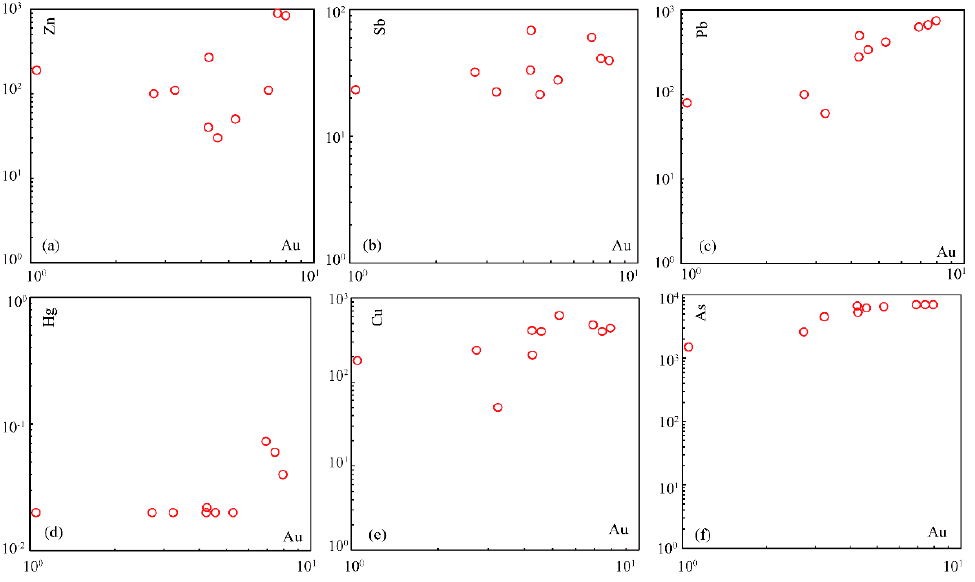
Figure 8. Geochemical plots of Au versus other ore-forming elements. All of the elements are given in ppm.